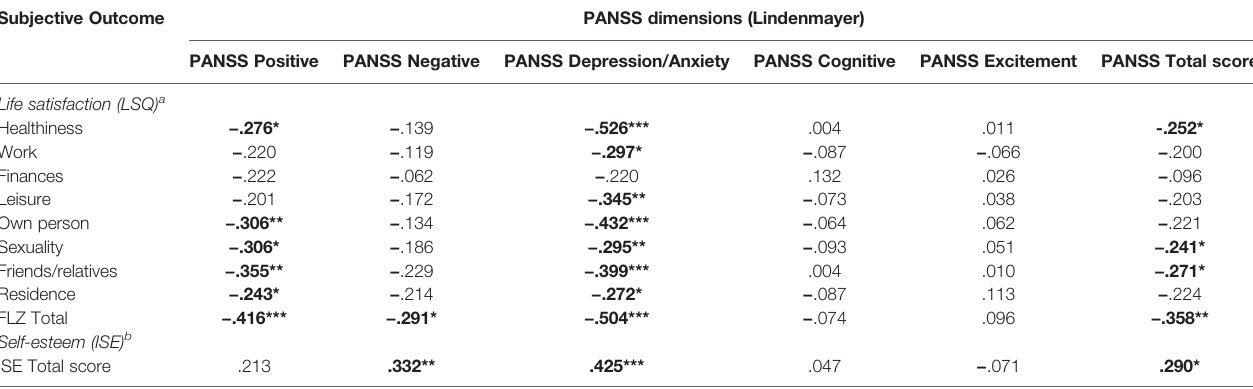
TABLE 2 | Association of psychopathology with life satisfaction and self-esteem (Spearman rank correlation). Subjective Outcome